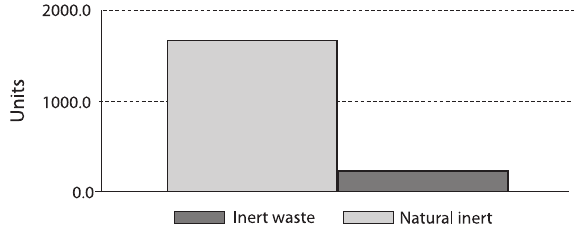
Fig. 6. Energy consumption with Cumulative Energy Demand